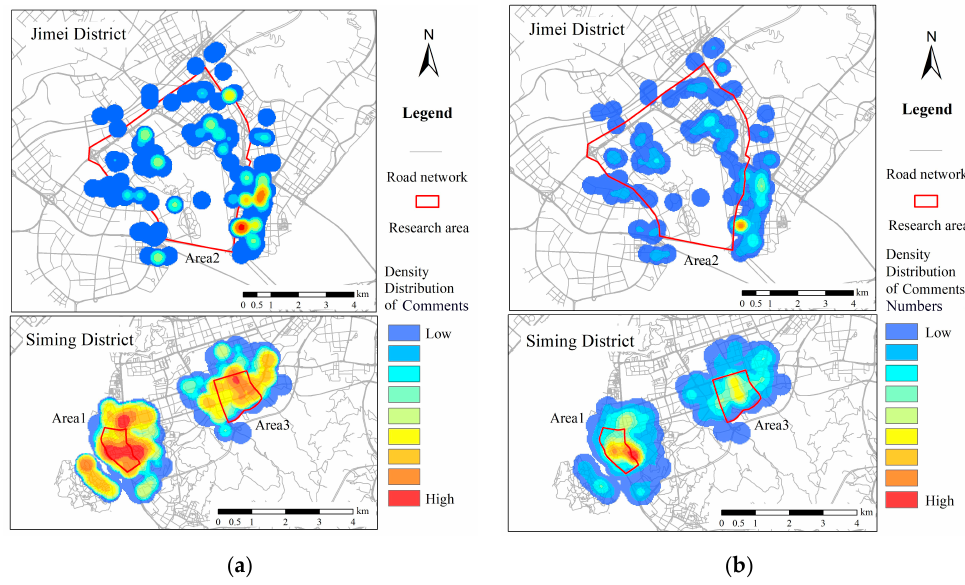
Figure 12. Visualisation results of ( a ) density distribution of comment data and ( b ) density distribu- tion of the number of